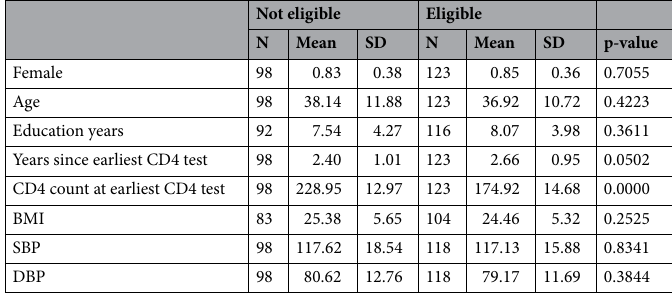
Table 1. Balance checks for the ± 50 CD4 cells/μl